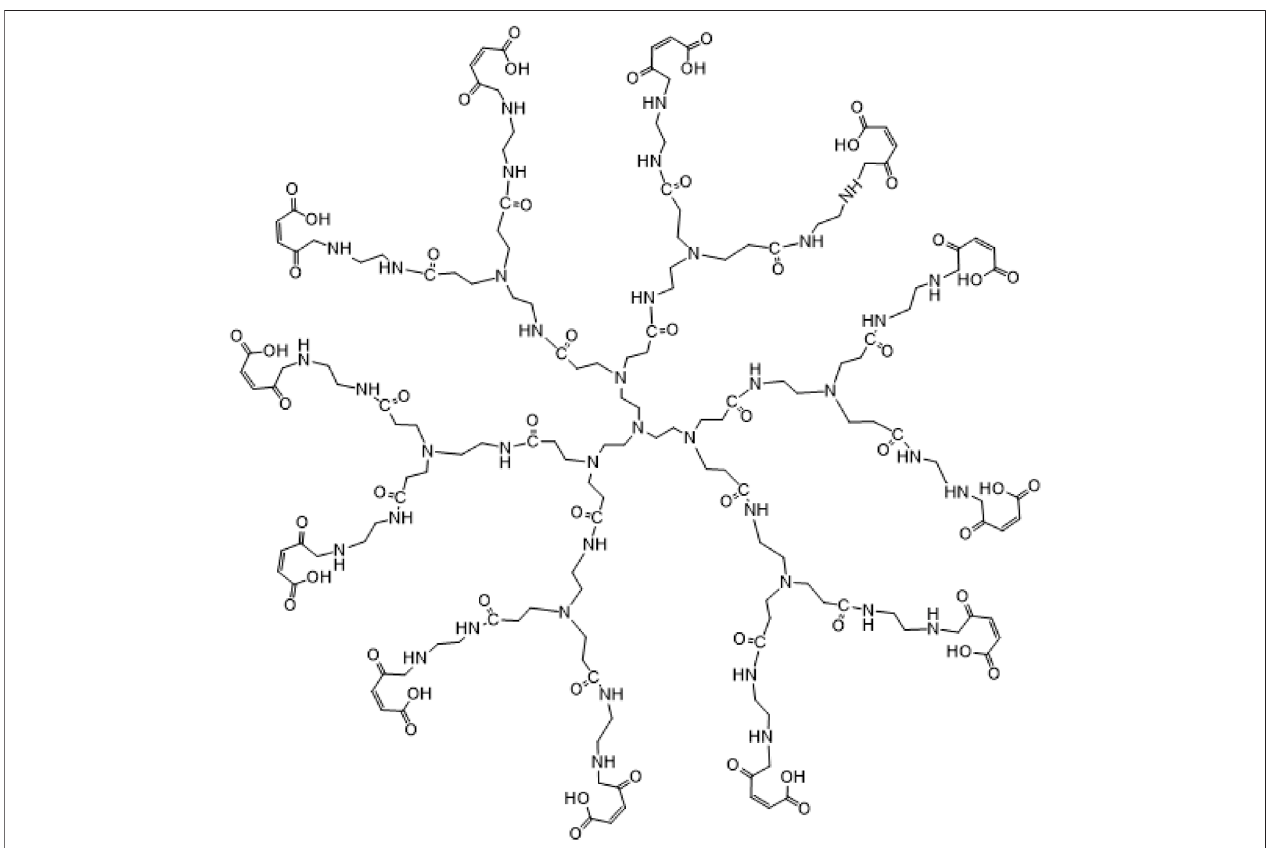
FIGURE 15 | Third-generation polyamidoamine